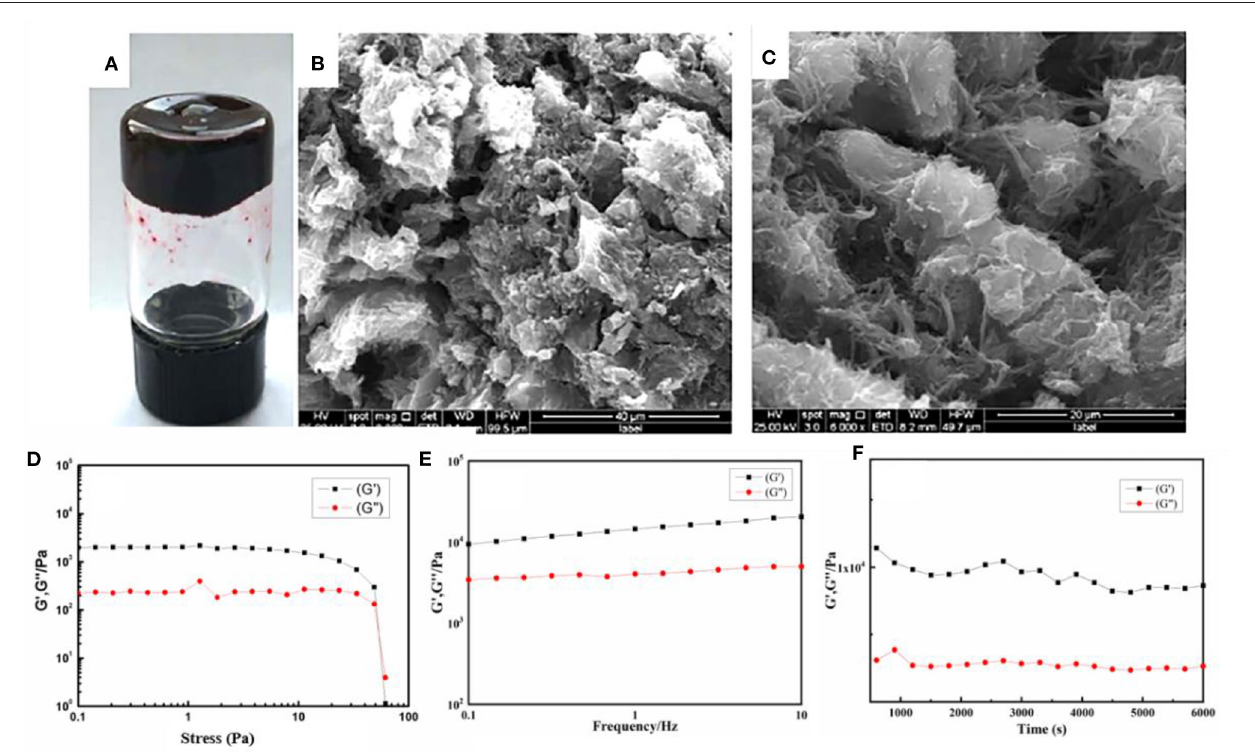
FIGURE 3 | (A) Photo of the NAAPD–niclosamide derivatives (NMD)-loaded gel, SEM images of the samples (B) for NAAPD drug-loaded in larger scale, (C) for NAAPD–NMD-loaded gel in small scale, (D) strain sweep for NAAPD–NMD-loaded gel at 5% w/v, (E) frequency sweep of the NAAPD–NMD-loaded gel at the strain of 0.1%, and (F) time sweep of the NAAPD–NMD-loaded gel at the strain of 30%.